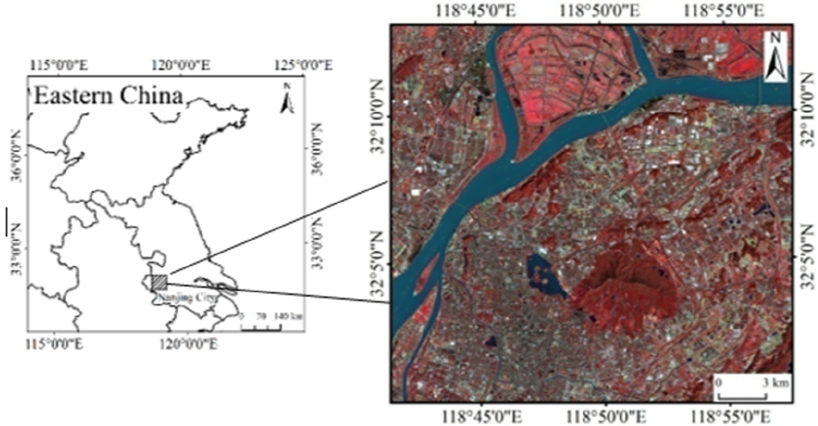
Figure 1. Location of the study area and a Landsat 8 OLI image of the area acquired on 21 July 2017 (red, Band 4; green, Band 3; blue, Band